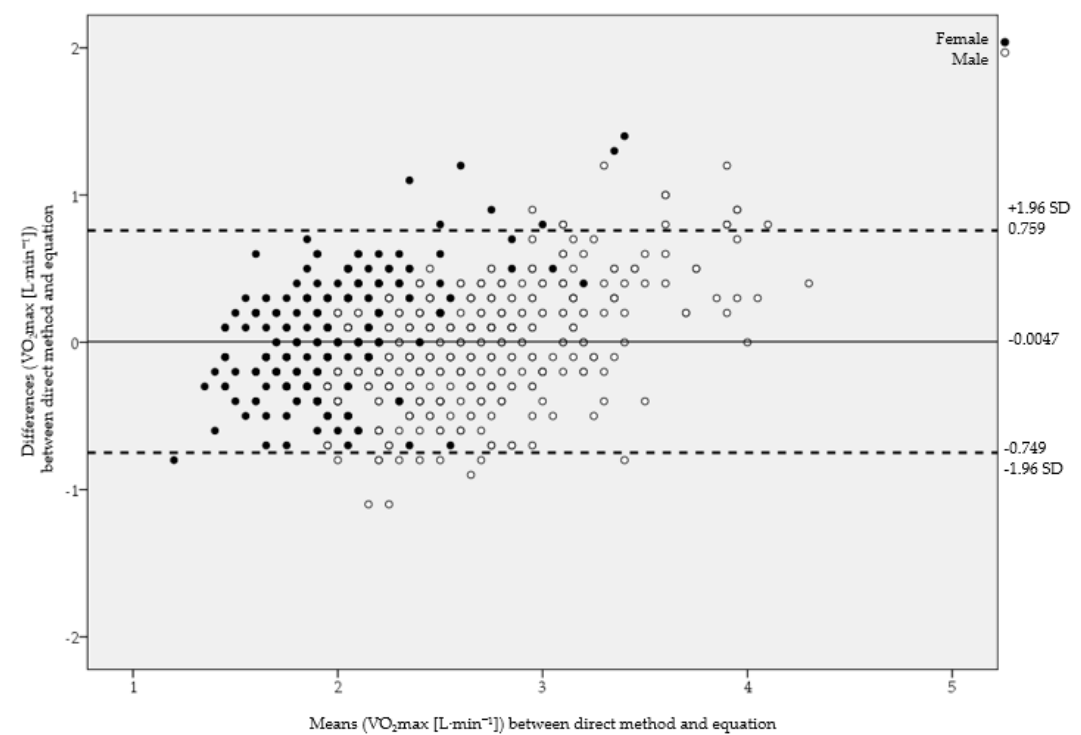
Figure 3. Bland–Altman diagram: agreement between criteria method and equation.